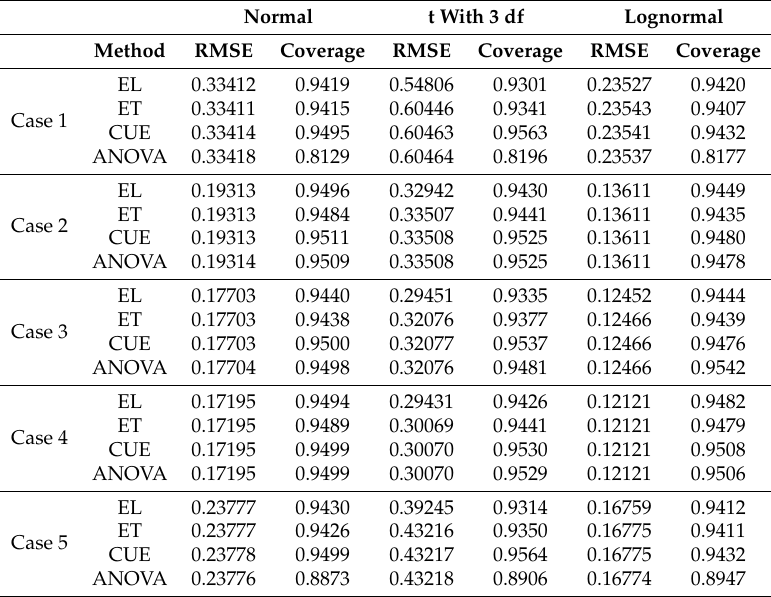
Table 4. Estimated root mean squared error and empirical coverage of nominal 95% confidence intervals (no covariates).